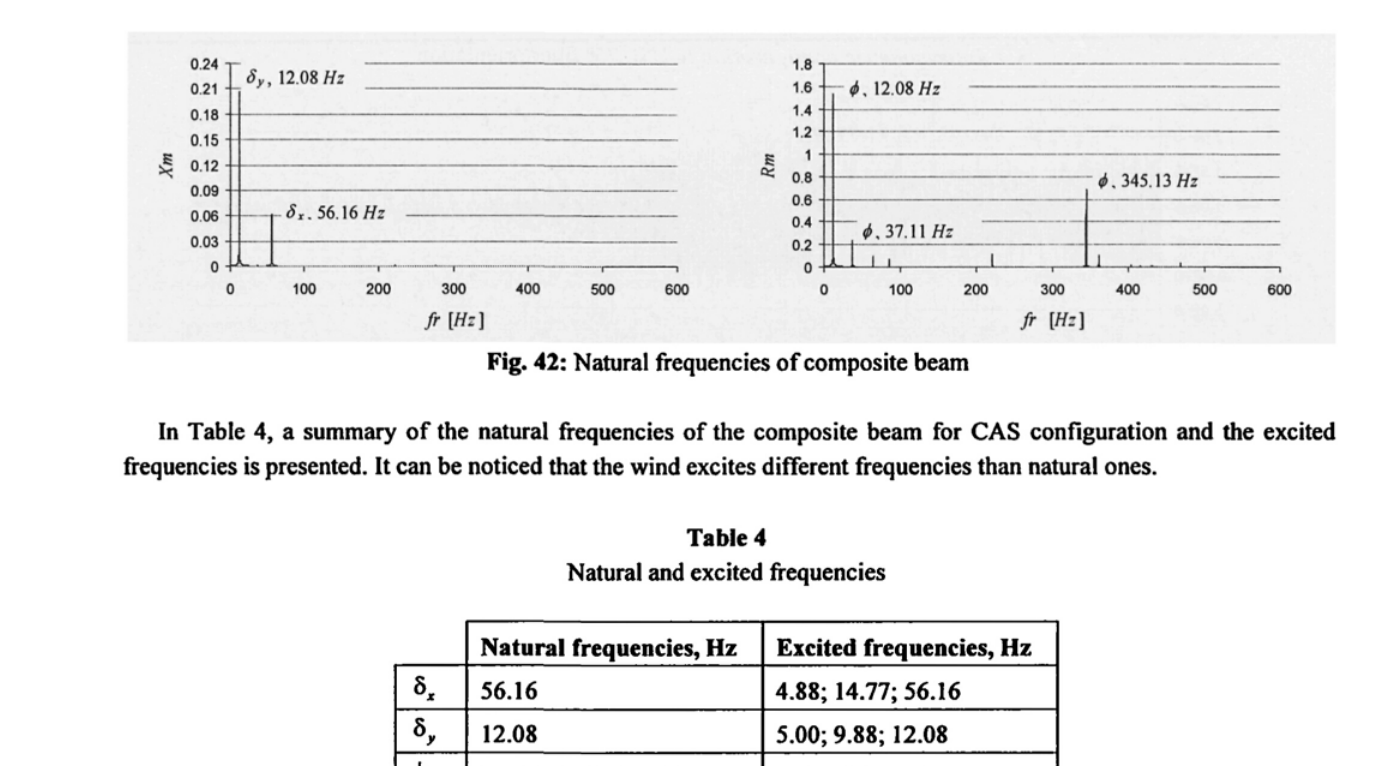
Fig. 42: Natural frequencies of composite beam